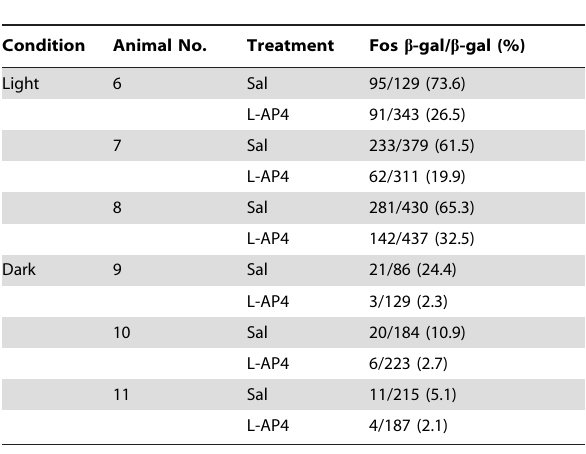
Table 2. Intraocular application of L-AP4 inhibits light- induced Fos expression in M1 ipRGCs lacking